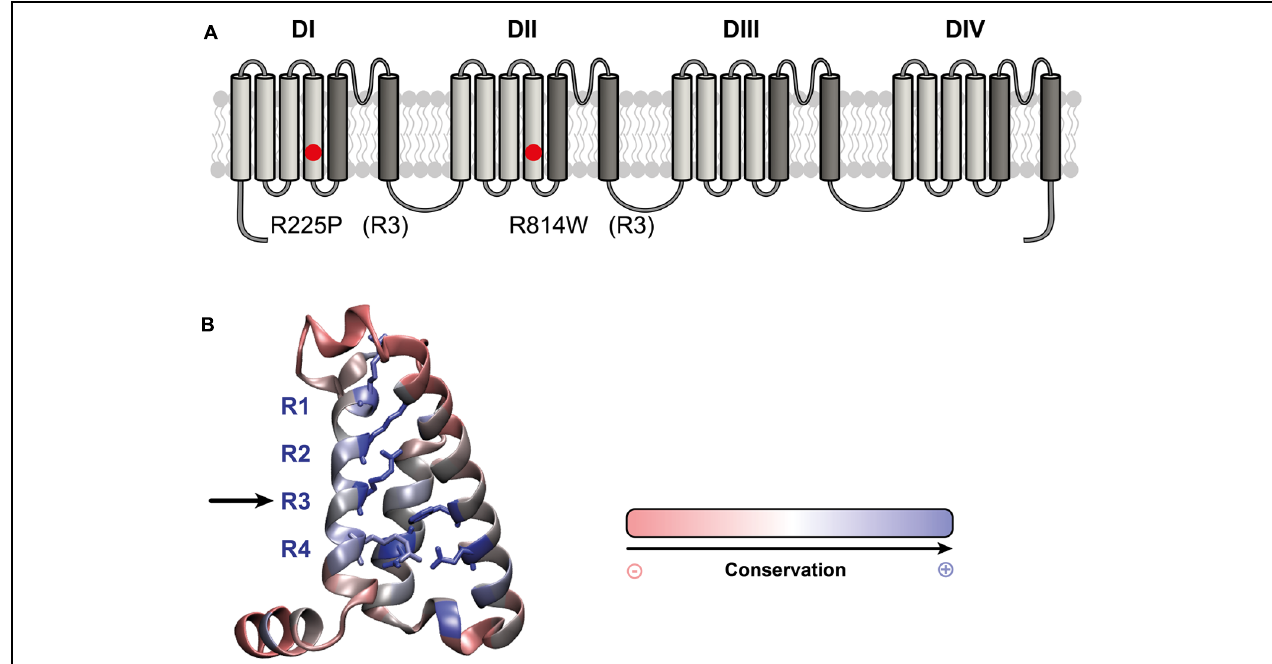
FIGURE 1 | Location of the R225P and R814W mutations that target highly conserved residues in VSDs. (A) 2D structure of Na v 1.5 channels showing the 24 TM segments organized into 4 domains (DI-DIV), each containing 6 TM. The S1-S4 segments of each domain form the VSD (light gray) while the assembly of the S5–S6 segments (dark gray) form the pore of the channel. The locations of the R225P and R814W mutations are indicated by red circles. (B) 3D crystal structure of the VSD of Na v Ab channel showing the residues that are conserved in all VSDs. These residues were determined by calculating the Shannon entropy at every position for the 6,652 VSD sequence alignments reported by (Palovcak et al., 2014). Highly conserved residues are in blue while less conserved residues are in red. The S1 segment was removed for purposes of clarity. The positively charged residues of the S4 segment (left) are highly conserved as are the residues forming the GCTCs of the S2 and S3 segments (right and middle